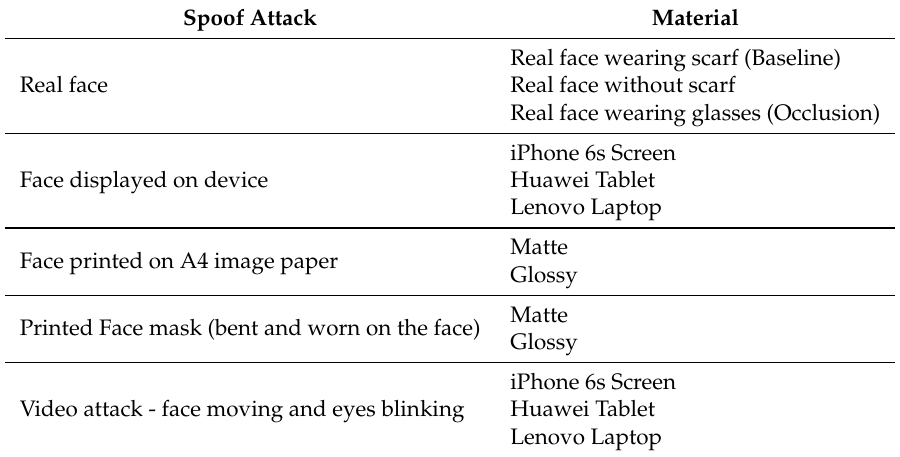
Table 3. Summary of spoof attacks.